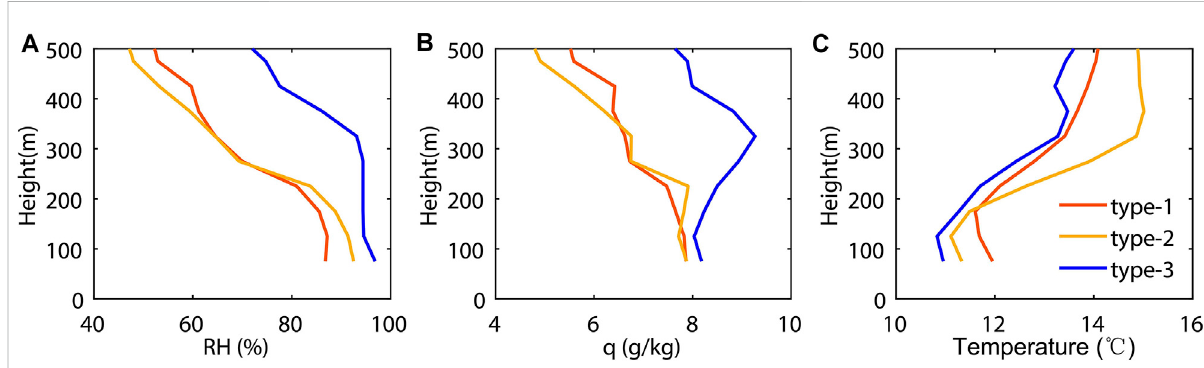
FIGURE 11 Composite results of vertical RH ( A ; %), q ( B ; g/kg), and temperature ( C ; ° C) based on sounding data (75 m above the sea level). Red, yellow, and blue curves represent type-1, type-2, and type-3 SFP events,